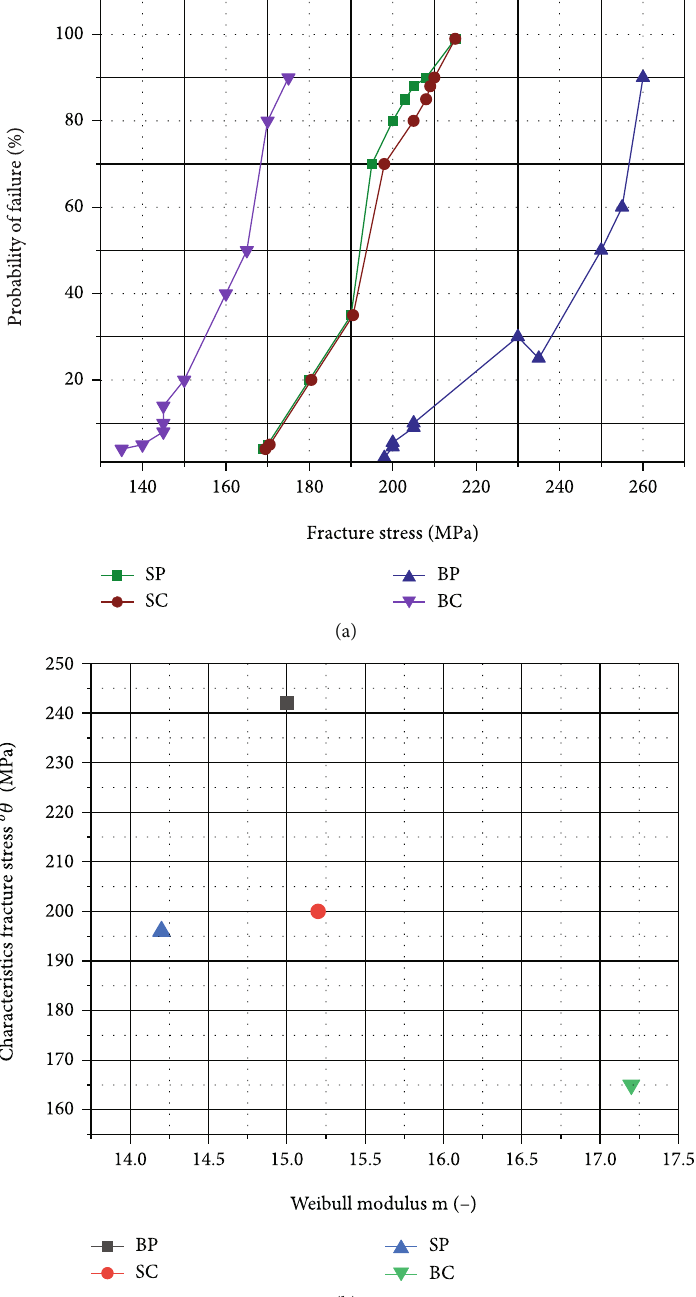
Figure 6: Analysis of four-point bending tests using solar cell in various parameters. MLE (a) Weibull drawing and (b) Weibull constraints with 95% assurance intervals are